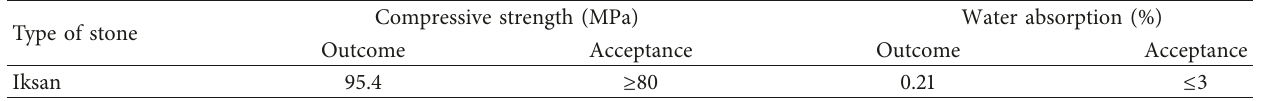
Table 4: Mechanical properties of natural surface